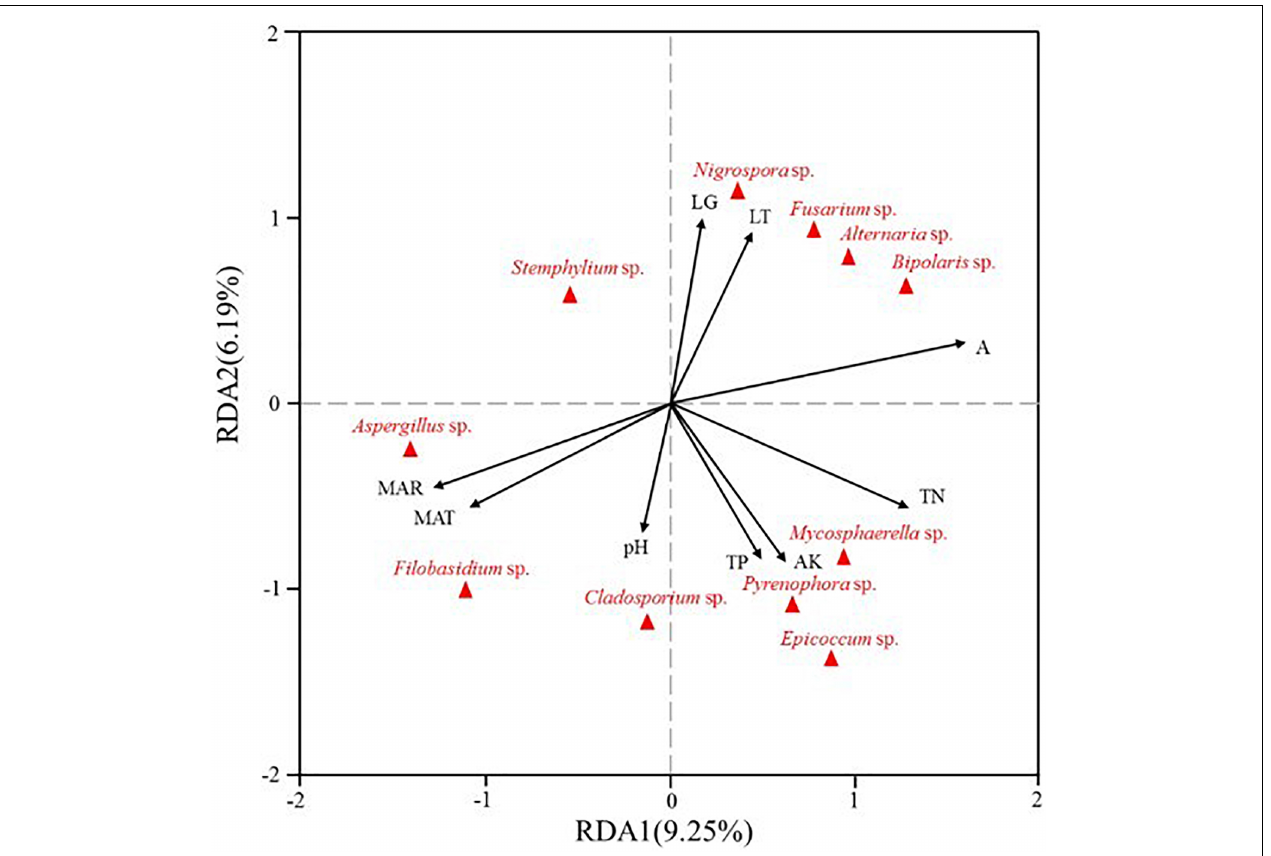
FIGURE 6 | Redundancy analysis (RDA) of relative abundance of seed-borne fungal genera from three different regions (LG: longitude, LT: latitude, A: altitude, MAR: mean annual rainfall, MAT: mean annual temperature, TN: total N, TP: total P, AK: available K, pH).